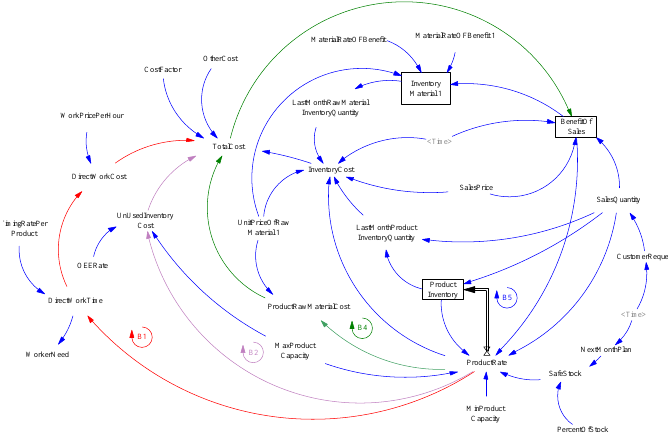
Fig. 2. The proposed structure of the proposed